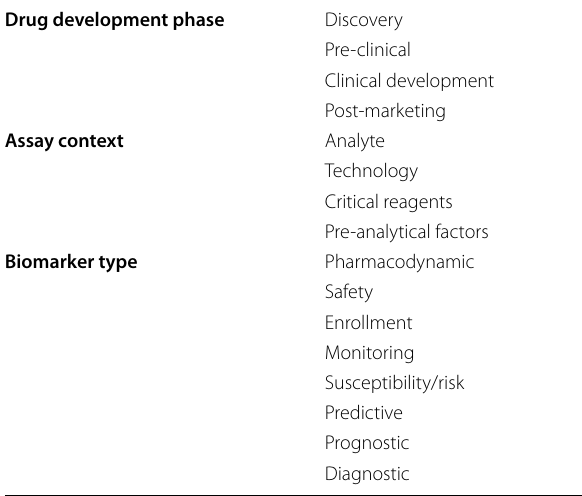
Table 1 Categories for considerations when establishing context of use. Multiple factors need to be considered